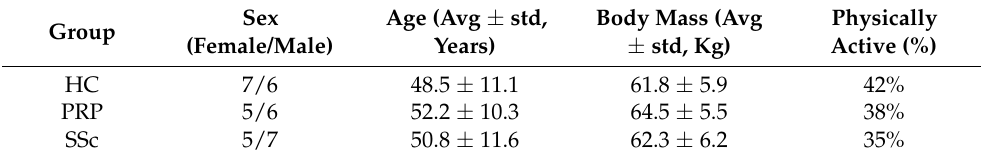
Table 1. Physical characteristics of the